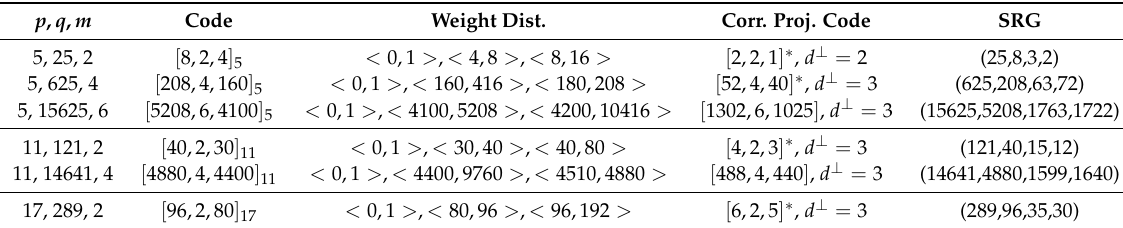
Table 2. Two-weight trace codes from nonzero